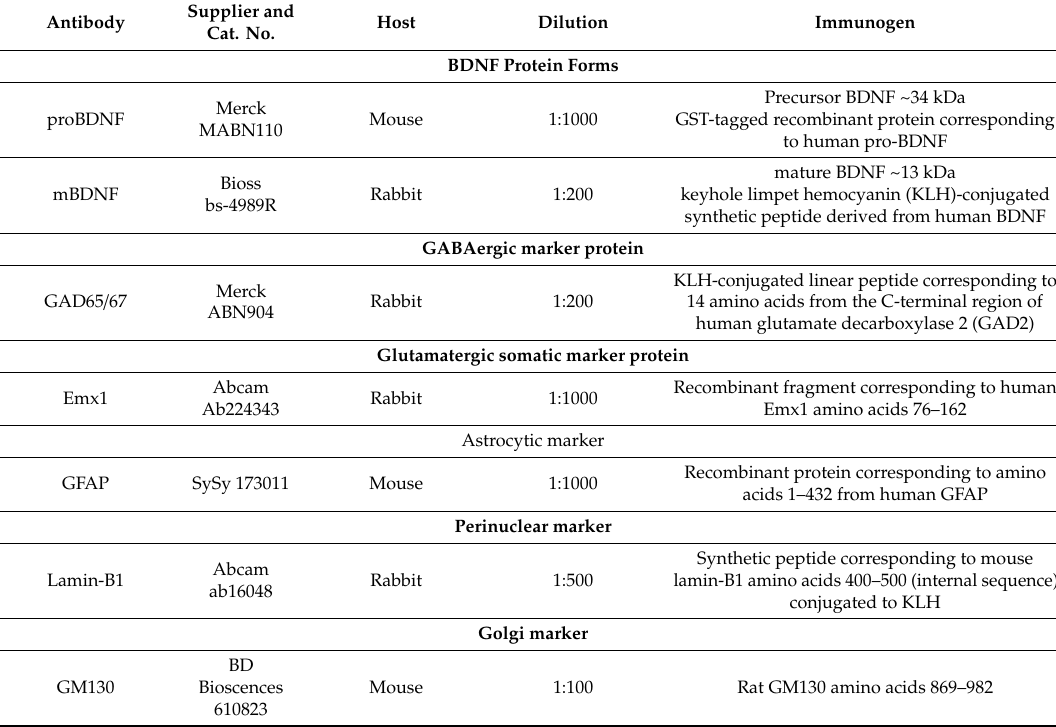
Table 5. List of primary Antibodies for